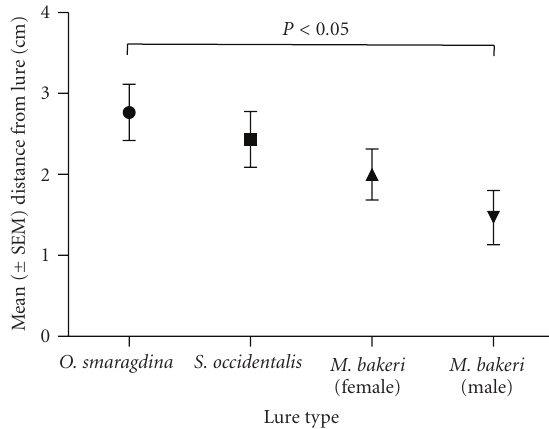
Figure 2: Mean ( ± SEM) approach distance by the spider-eating salticid Portia fimbriata to lures of ants ( Oecophylla smaragdina ) and ant mimics of varying degrees of accuracy of mimicry ( Synageles occidentalis and male and female Myrmarachne bakeri